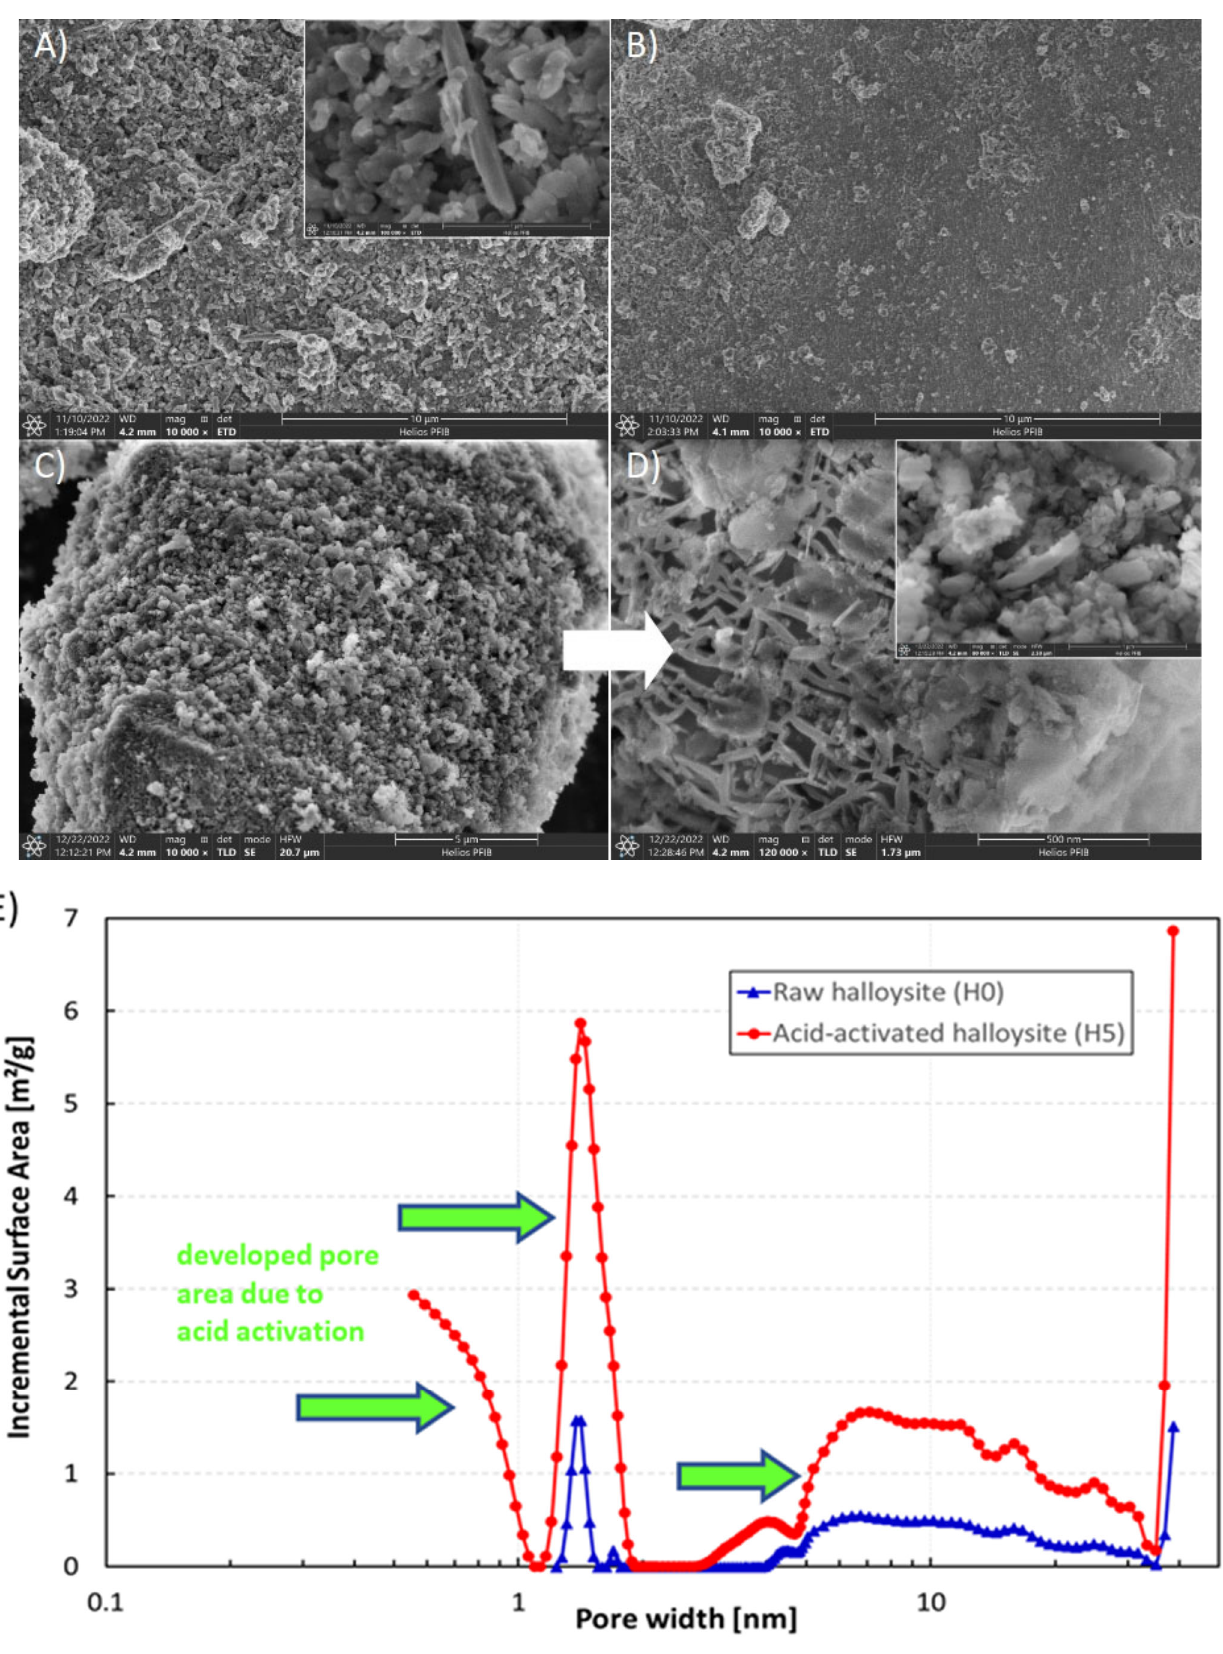
Figure 2. SEM Images of halloysite: ( A ) raw material (H0), ( B ) H 2 O 2 treated sample (H3), ( C ) and ( D ) H 2 SO 4 activated material (H5), ( E ) incremental surface area for raw (H0) and purified (H5) halloysite material. Table 3. The chemical composition of raw and modified halloysite samples obtained from SEM ‐ EDX analysis. Values present a percentage of particular elements in the analyzed sample. Samples, treatment details, and names are described in Table 2. Sample Name H0